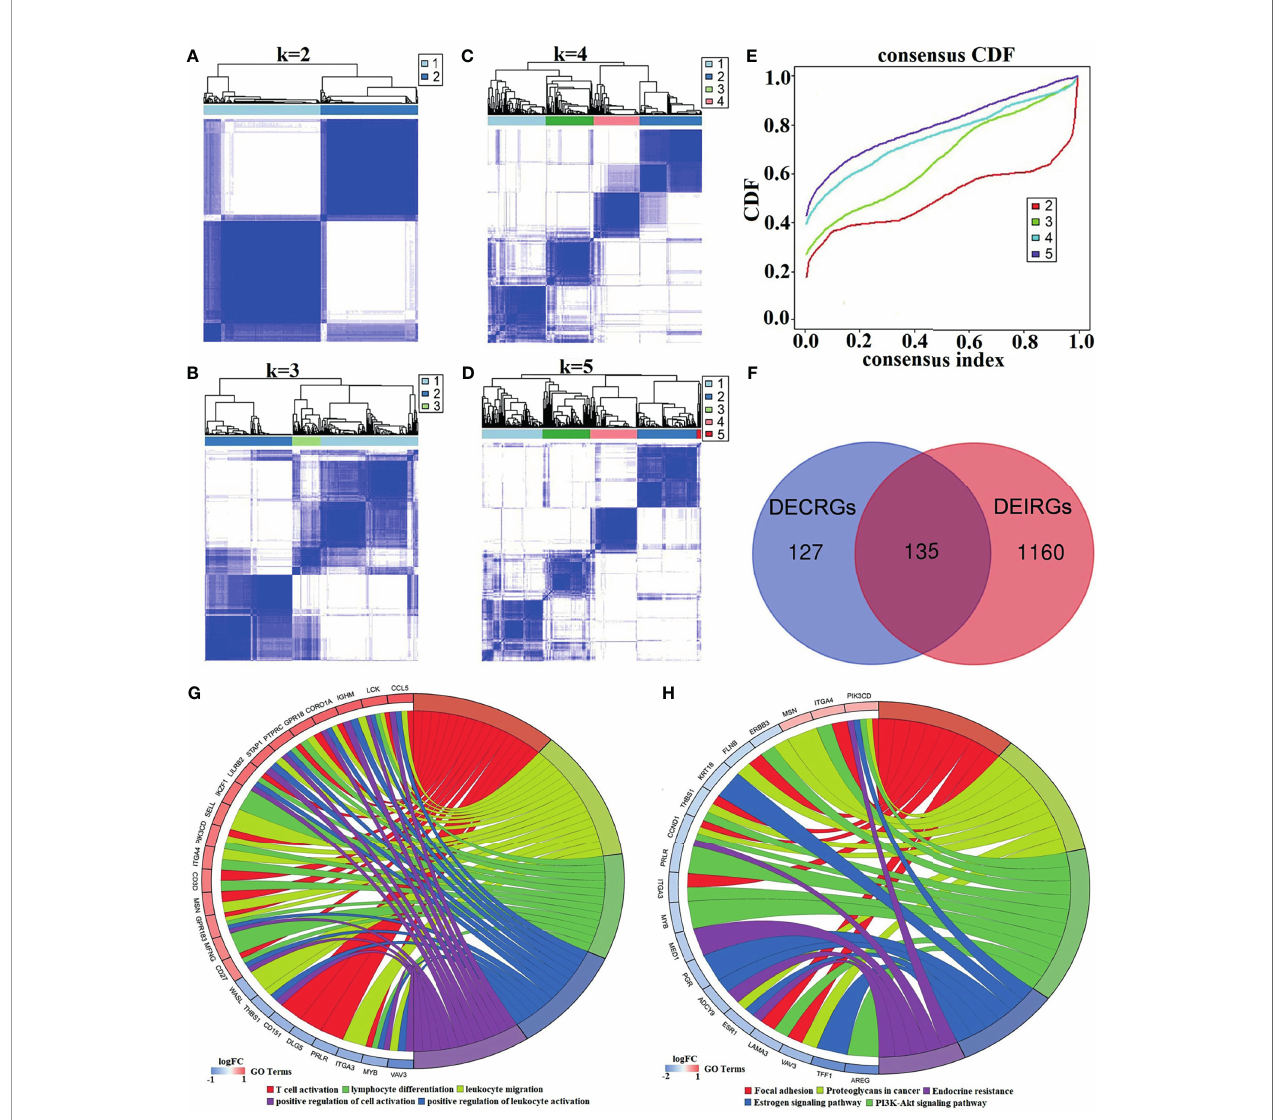
FIGURE 3 | The process of identifying K values and DECIRGs and the results of the enrichment analysis. (A – D) The consensus matrix (CM) plots. (A) K = 2; (B) K = 3; (C) K = 4; (D) K = 5. (E) The cumulative distribution function (CDF) plots. (F) Venn plot of the intersection of DECRGs and DEIRGs. (G) The GO enrichment results of the 135 DECIRGs (only the top 5 items). (H) The KEGG enrichment results of the 135